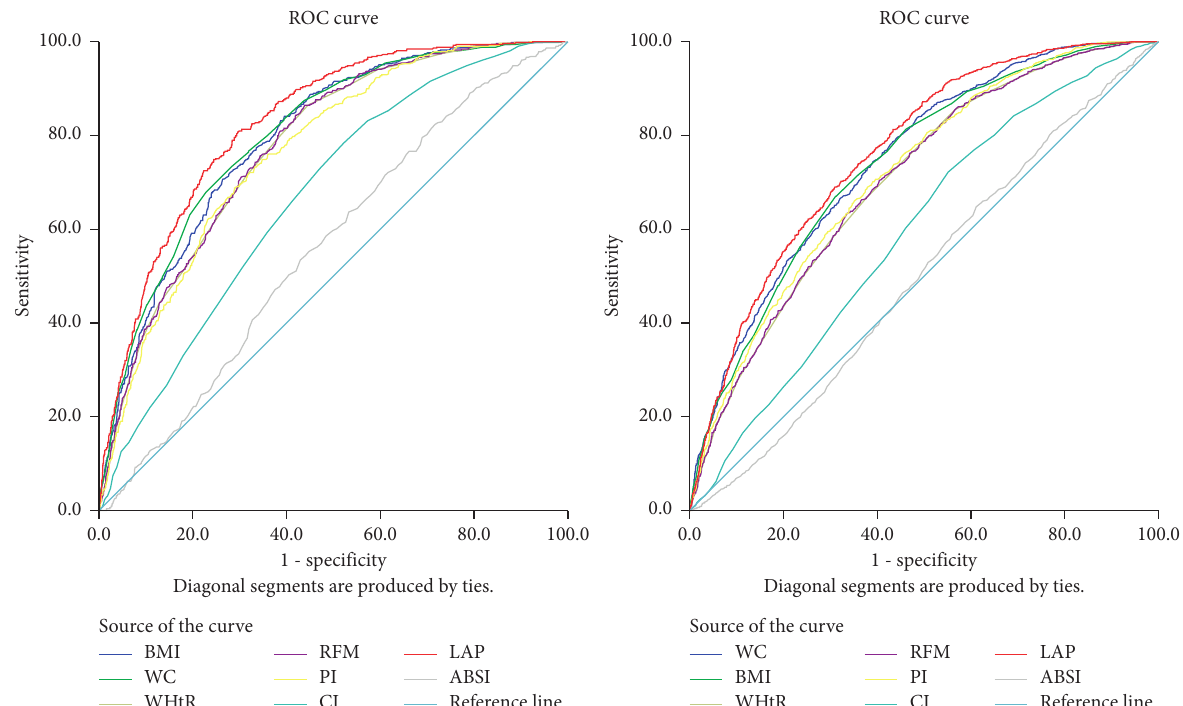
Figure 2: ROC curve showing the performance of different anthropometric indexes in predicting